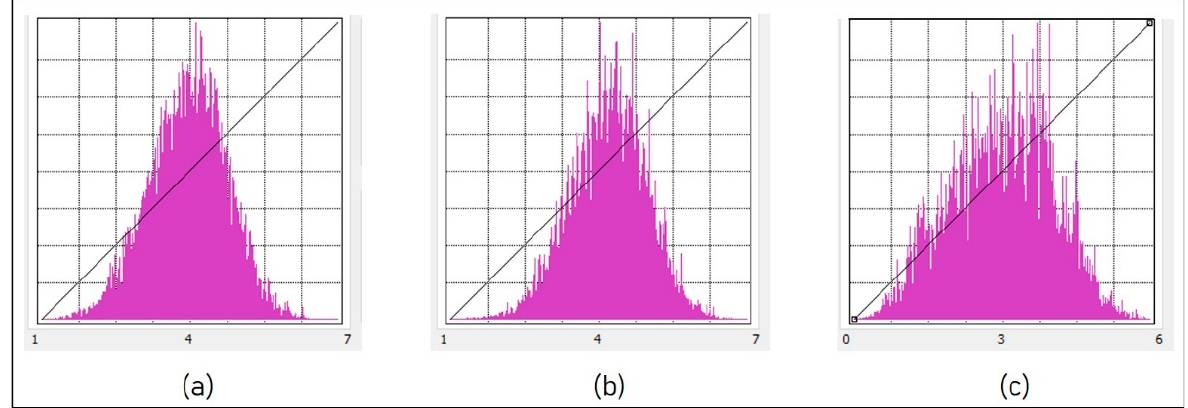
Figure 11. Histogram analysis of LSM model: ( a ) AHP; ( b ) fuzzy-AHP; ( c ) ANN. Additionally, three susceptibility maps based on the known landslide dataset were utilized to assess the dependability of the results using the area under the curve (AUC) of the receiver operating characteristics (ROC). A map of landslide inventory was produced from published data of the Geological Survey of India. Here, 114 landslides were recorded; 79 (70 percent) were utilized as training data and 35 (30 percent) as testing data. The maps created by the ANN model appear to be more accurate than the maps created by the Fuzzy- AHP and AHP models, as shown by the AUC values of 88.1 percent, 86.1 percent, and 85.4 percent for ANN, fuzzy-AHP, and AHP, respectively. Time is a significant component in hazard studies; therefore, this discovery is helpful in an emergency. One may understand the conclusion that the models’ accuracy is equivalent. Because they can provide perfect and stable landslide susceptibility maps for risk mitigation and management planning, we advocate employing ANN, fuzzy-AHP, and AHP models in landslide investigations.